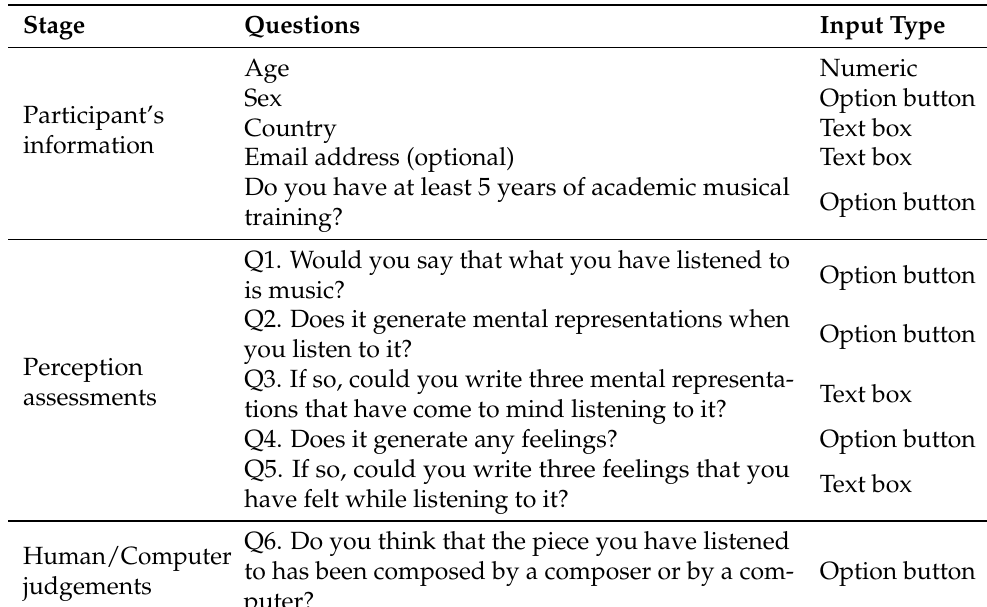
Table 3. Information requested to participants and questions to interrogate the personal opinion and feelings elicited by the